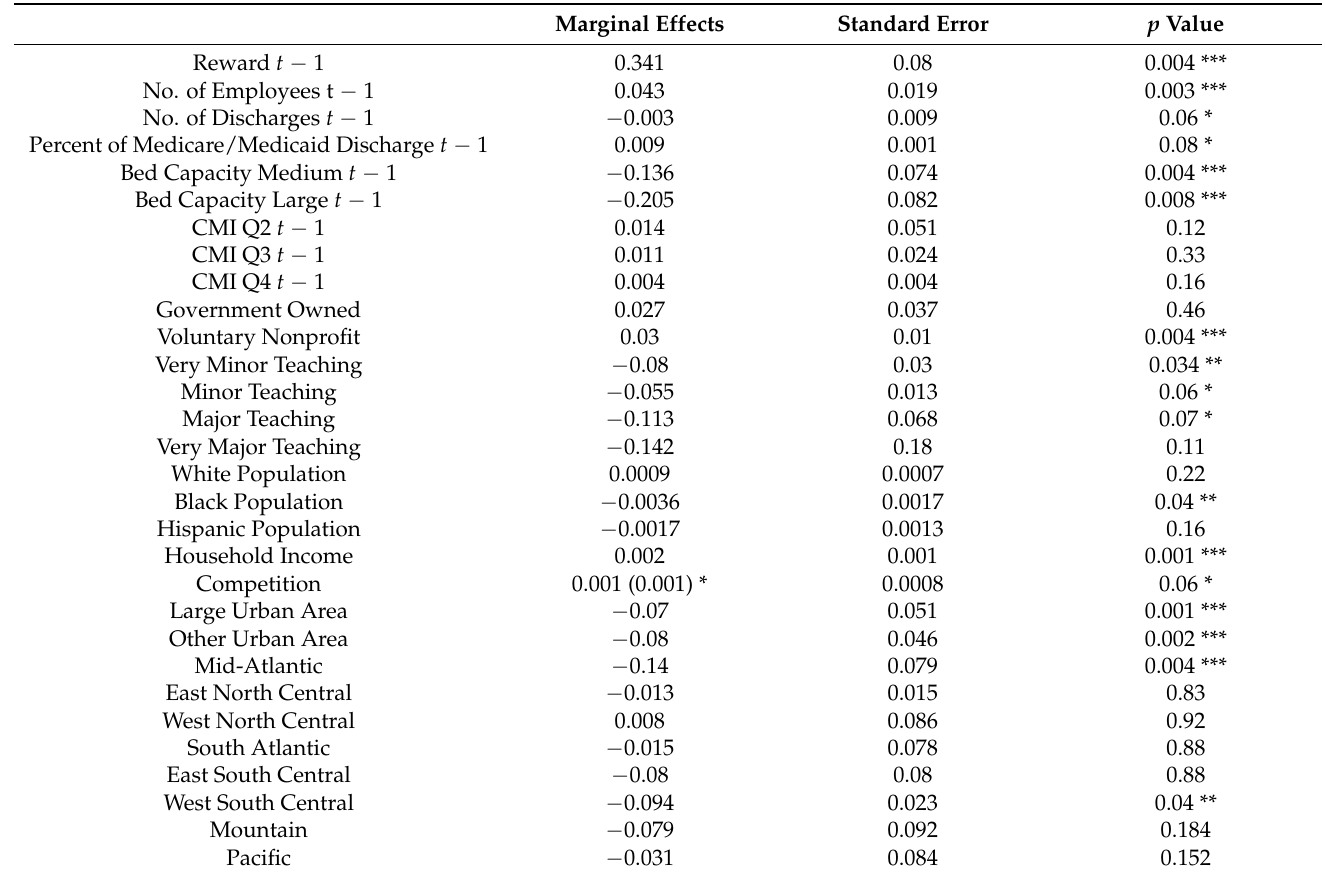
Table 7. Results of model estimates of marginal